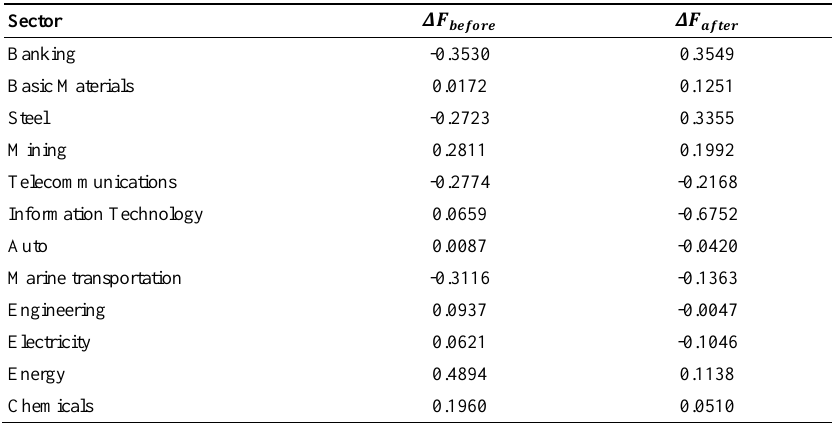
Table 15. The net information outflow for the sectors in TSE market, before and after COVID-19 outbreak – evaluated through the symbolic coding scheme of Equation